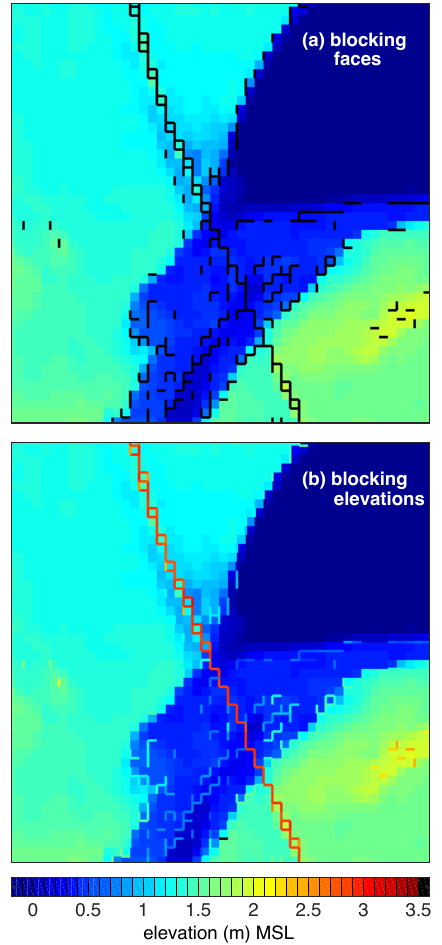
Figure 7. The snap-grid and cell-center blocking methods applied to the median-filtered background topography from Fig. 2. In (a) the locations of all blocked faces are shown; in (b) , the blocked faces are given colors corresponding to their blocking